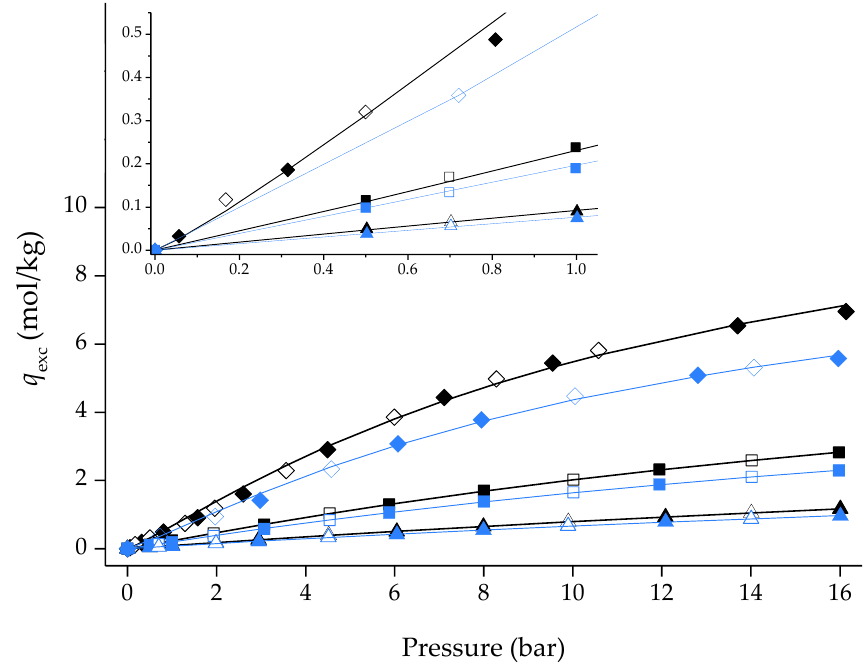
Figure 7. CO 2 , CH 4 and N 2 adsorption/desorption equilibrium isotherms at 303 K for ZIF-8 and [C 6 MIM][B(CN) 4 ]@ZIF-8 (low) composite (with an inset for the low-pressure region). Closed and open symbols denote the adsorption and desorption data, respectively. Lines represent the Sips adsorption isotherm model fitting [18] to the experimental points. Symbols: ◆ / ZIF-8_CO 2 ; ◆ / [C 6 MIM][B(CN) 4 ]@ZIF-8 (low)_CO 2 ; / ZIF-8_CH 4 ; / [C 6 MIM][B(CN) 4 ]@ZIF-8 (low)_CH 4 ; / ZIF-8_N 2 ; / [C 6 MIM][B(CN) 4 ]@ZIF-8 (low)_N 2 .